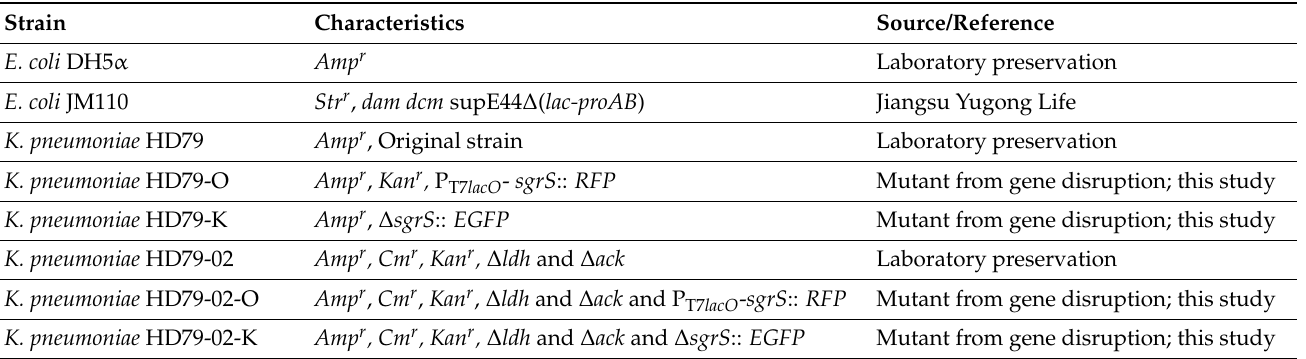
Table 1. Strains used in this